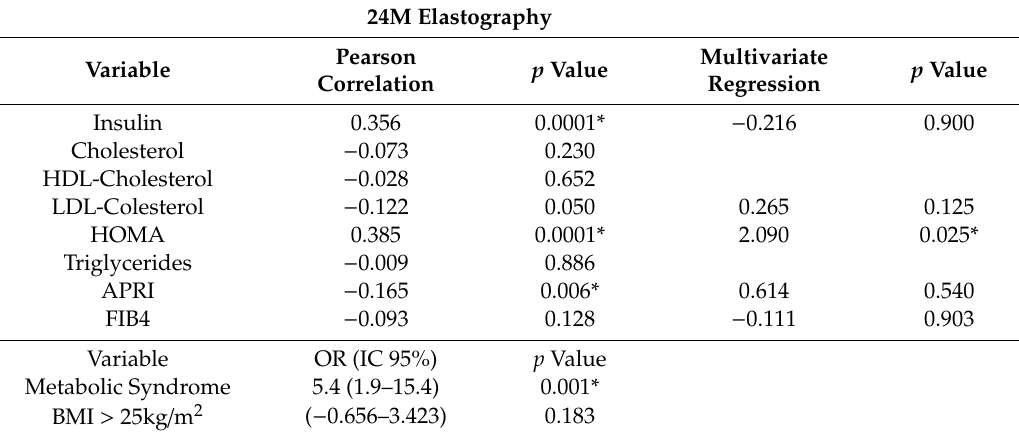
Table 2. Univariate and multivariate linear regression of Fibroscan ® values at 24 months. Univariate analysis showed significant logistic correlation between values of insulin, LDL-cholesterol, HOMA, and APRI. In multivariable analysis, the only one that maintained significance was HOMA. * p <